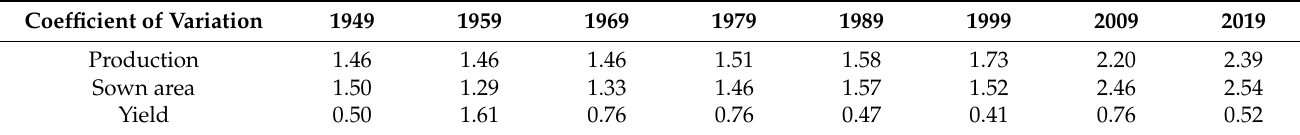
Table 1. Coefficient of variation of soybean production, sown area, and yield in China from 1949 to